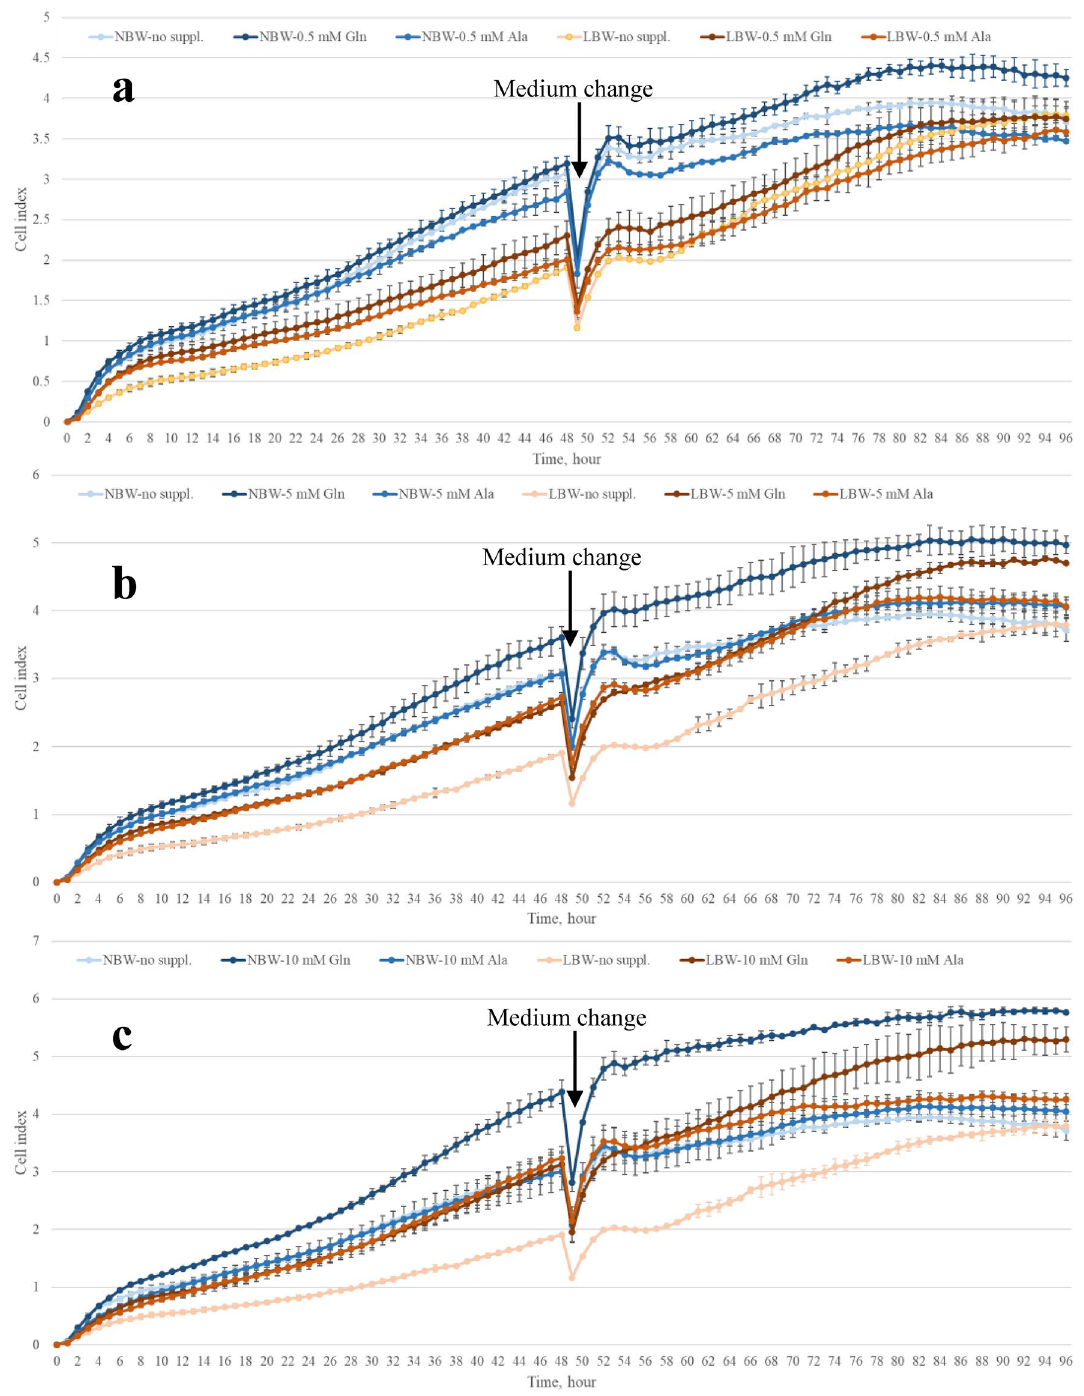
Figure 4. Cell indexes of proliferating myogenic cells. Cell indexes were recorded for myogenic cells with the xCELLigence RTCA-DP device. Cells, isolated from M. longissimus of low birth weight (LBW) and normal birth weight (NBW) piglets at 4 dpn, were supplemented with 0.5 mM Gln or Ala ( a ), 5 mM Gln or Ala ( b ), 10 mM Gln or Ala ( c ) and compared with myogenic cells without supplementation (no suppl.). The basic medium contained 0.28 mM Gln and Ala. All values are presented as Means and SD (standard deviations) of three repetitive